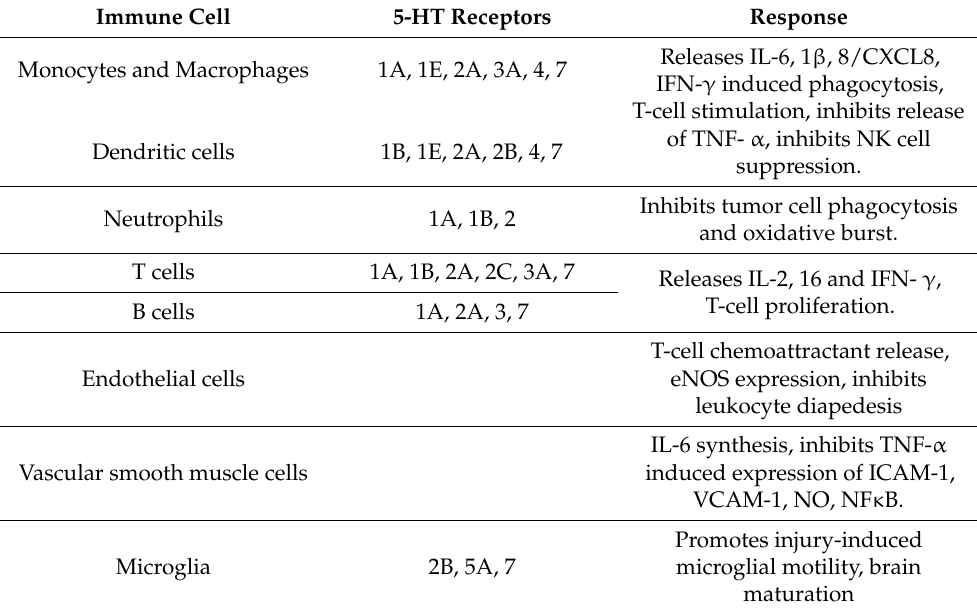
Table 2. Functions of serotonin in inflammation and